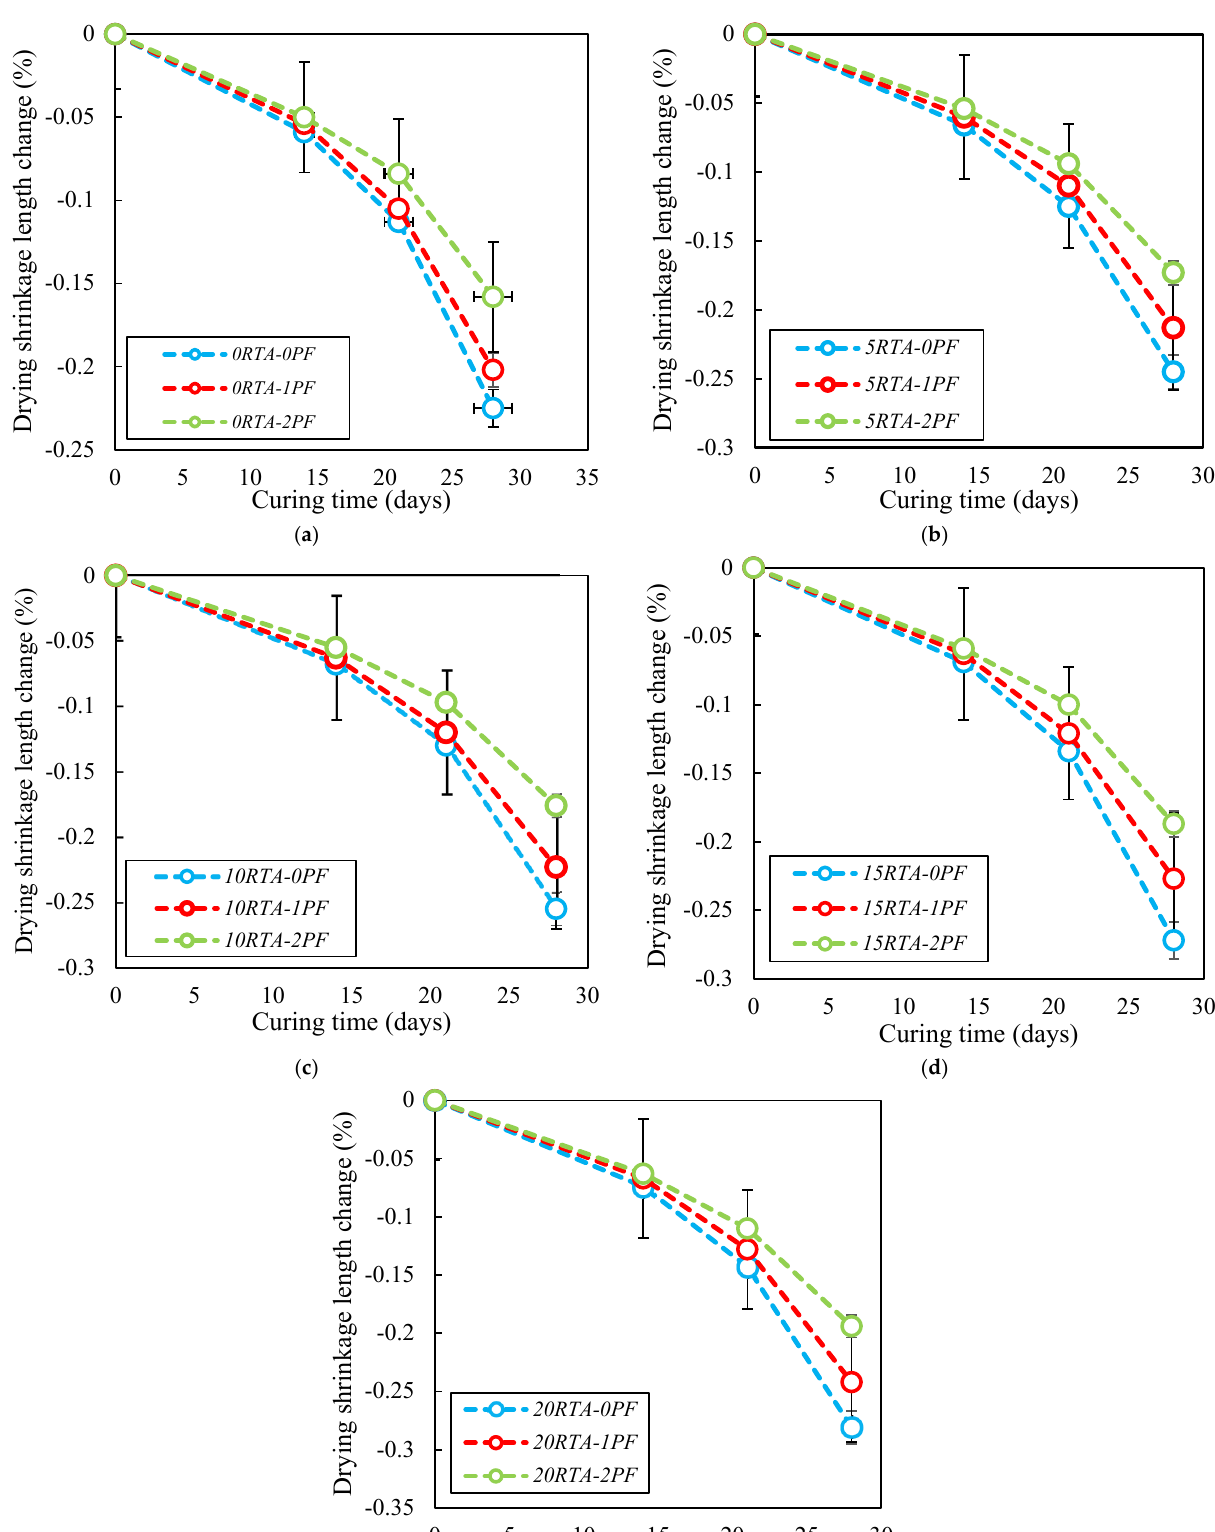
Figure 17. Influence of PF on the length variations due to shrinkage having: ( a ) 0% RTA; ( b ) 5% RTA; ( c ) 10% RTA; ( d ) 15% RTA and; ( e ) 20% RTA.